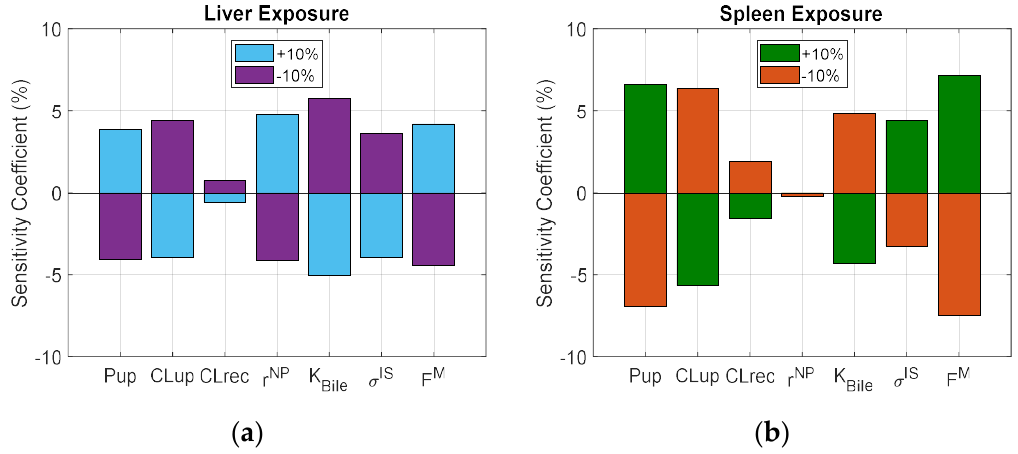
Figure 9. Sensitivity of liver ( a ) and spleen ( b ) exposures to relative perturbations in key parameters. Pup = maximum rate of phagocytosis, CLup = rate of pinocytosis, CLrec = rate of exocytosis, r NP = NP hydrodynamic radius, K Bile = rate of excretion into bile, σ IS = lymph reflection coe ffi cient and F M = macrophage fraction of